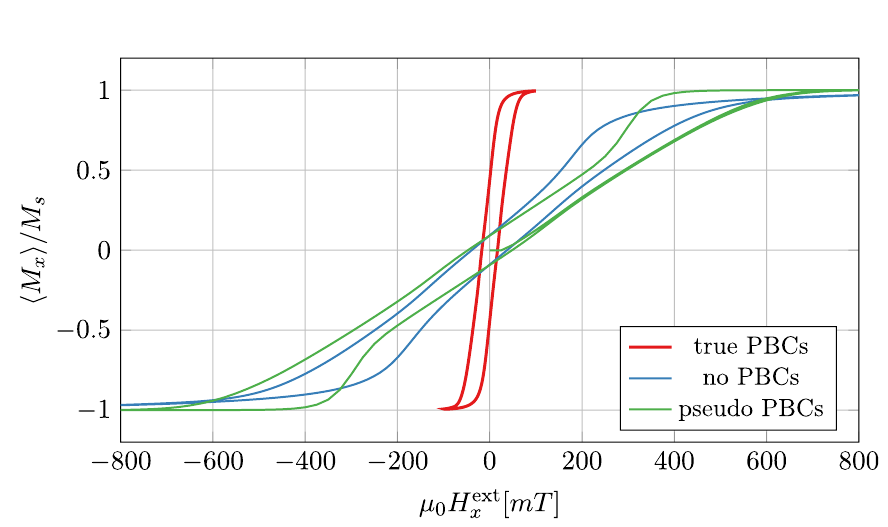
Figure 7. Finite difference hysteresis curves of the SMC material for interparticle widths w gap = 23.08 nm with different boundary conditions. Without true PBCs the external field range has to be extended to ± 2.5T , in order to fully saturate the